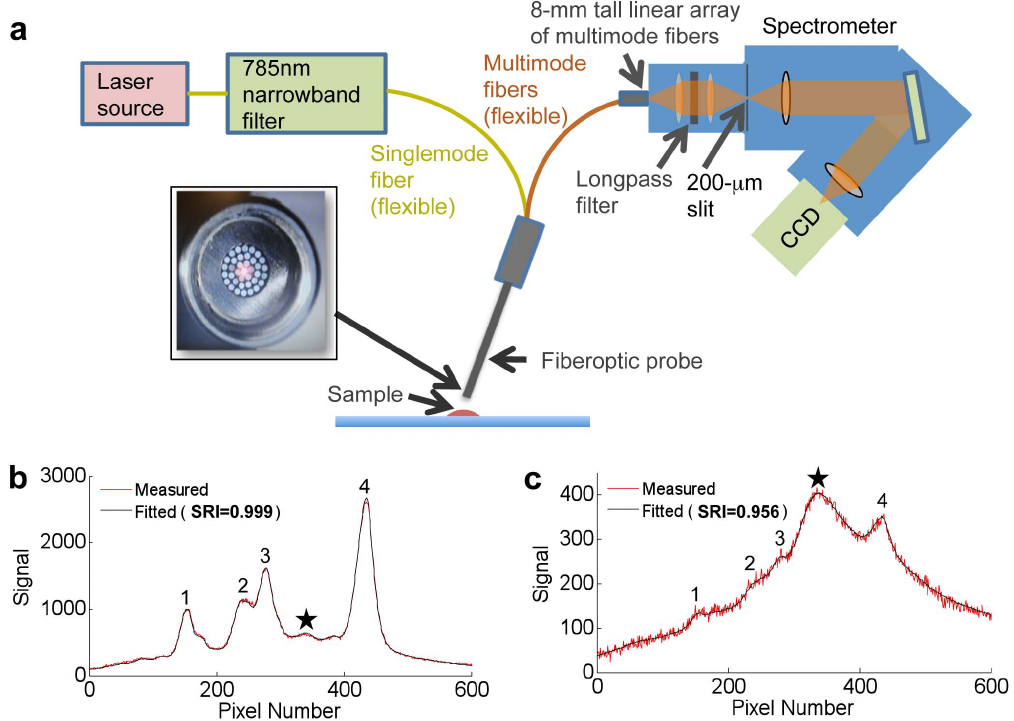
Figure 3. Measurement apparatus. (a) A spectrometer with CCD detector is used to capture Raman signals from a nanoparticle sample illuminated with a 785-nm laser source. See text for details. (b) Example of a strong signal with a high SRI and (c) a weak signal with a lower SRI, in which noise and broadband background signals increasingly dominate over the SERS signals. Representative SERS peaks are numbered 1–4 and the peak of the broadband background is labeled with a star.